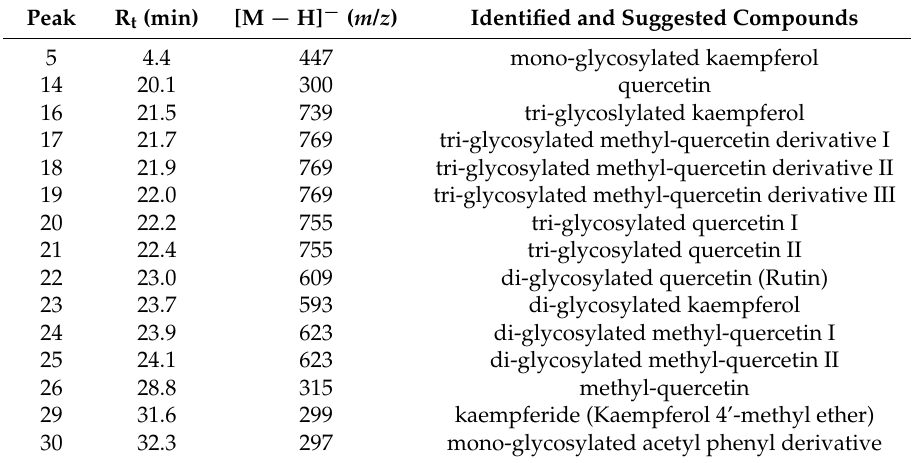
Figure 1. LC-MS/ESI chromatogram of OFIEOH from Opuntia ficus-indica . Numbers in the chromatogram refer to the compounds described in Table 1. Table 1. Polyphenol compounds of Opuntia ficus-indica essential oil (OFIEOH) identified by LC-MS/ESI. Peak